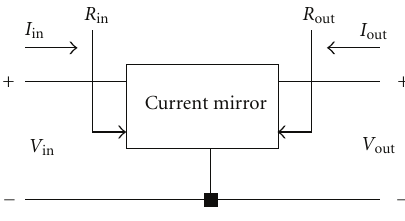
Figure 3: Block diagram of a current mirror.